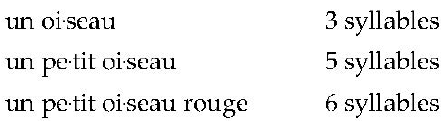
Figure 8. Arabic stress-timed rhythm.